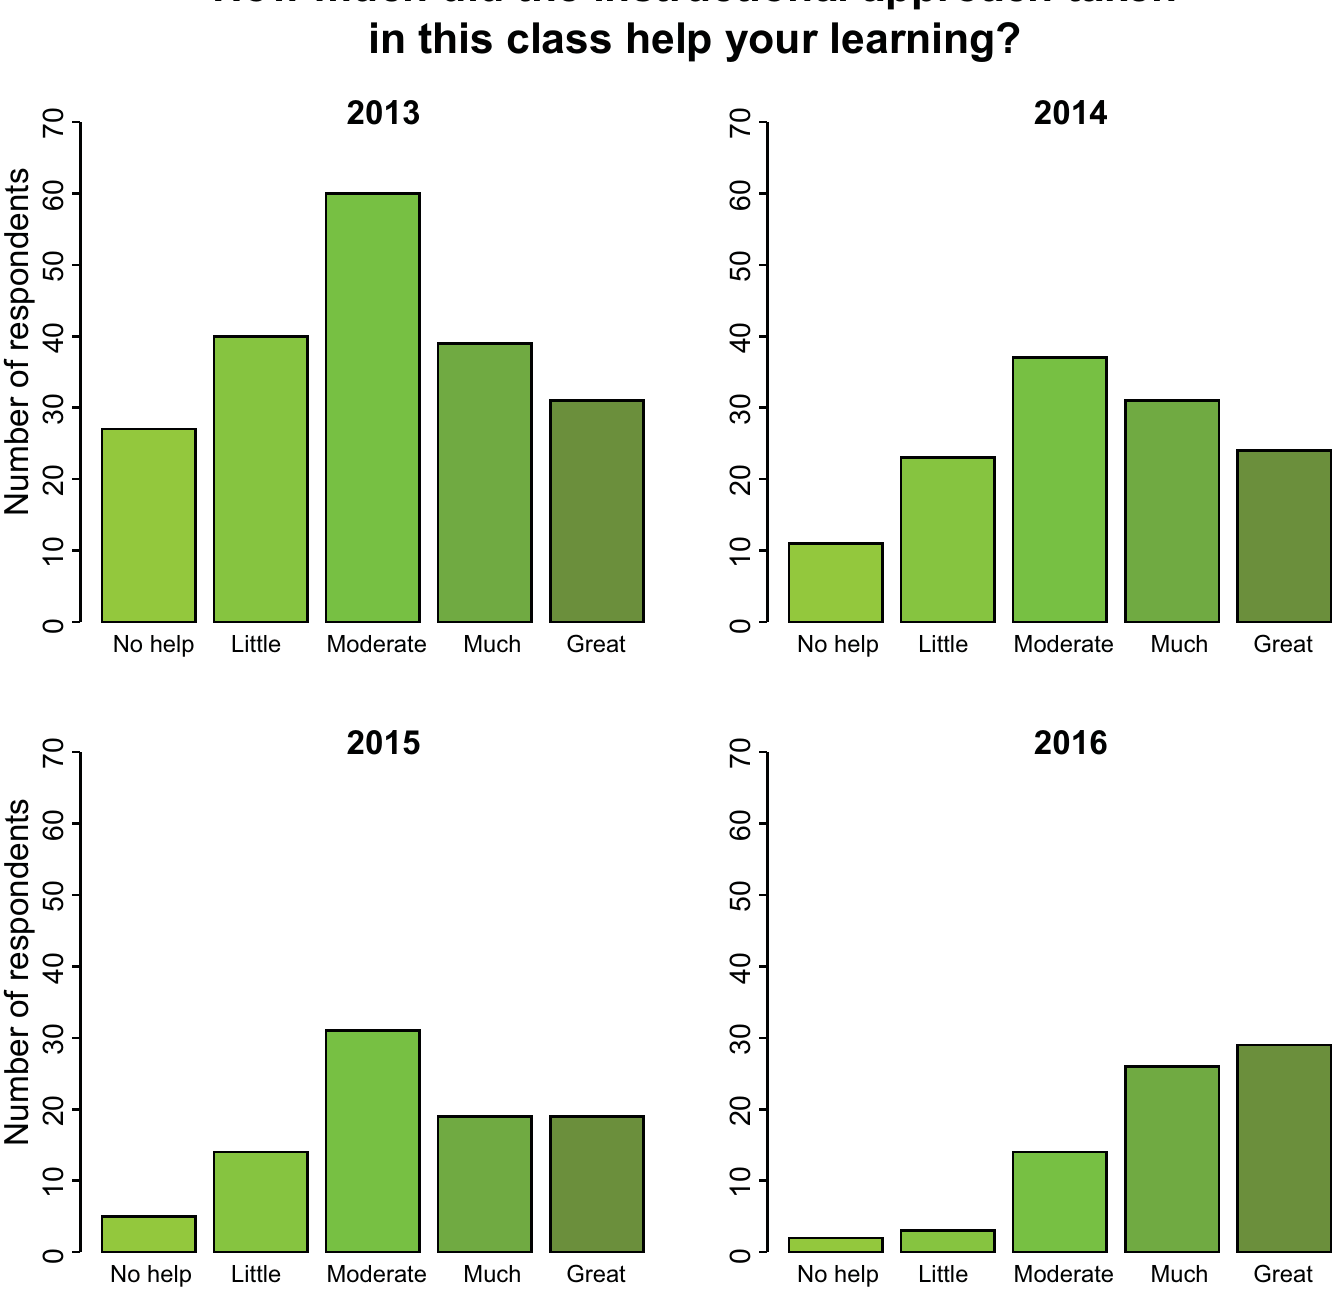
Fig 3. Change in student buy-in over time. Student responses shift over time, reducing the frequency of low rankings (No help, Little) relative to high rankings (Much, Great). Over four years, students increasingly report the instructional methods as responsible for large gains in their learning ( p < 0.0001).